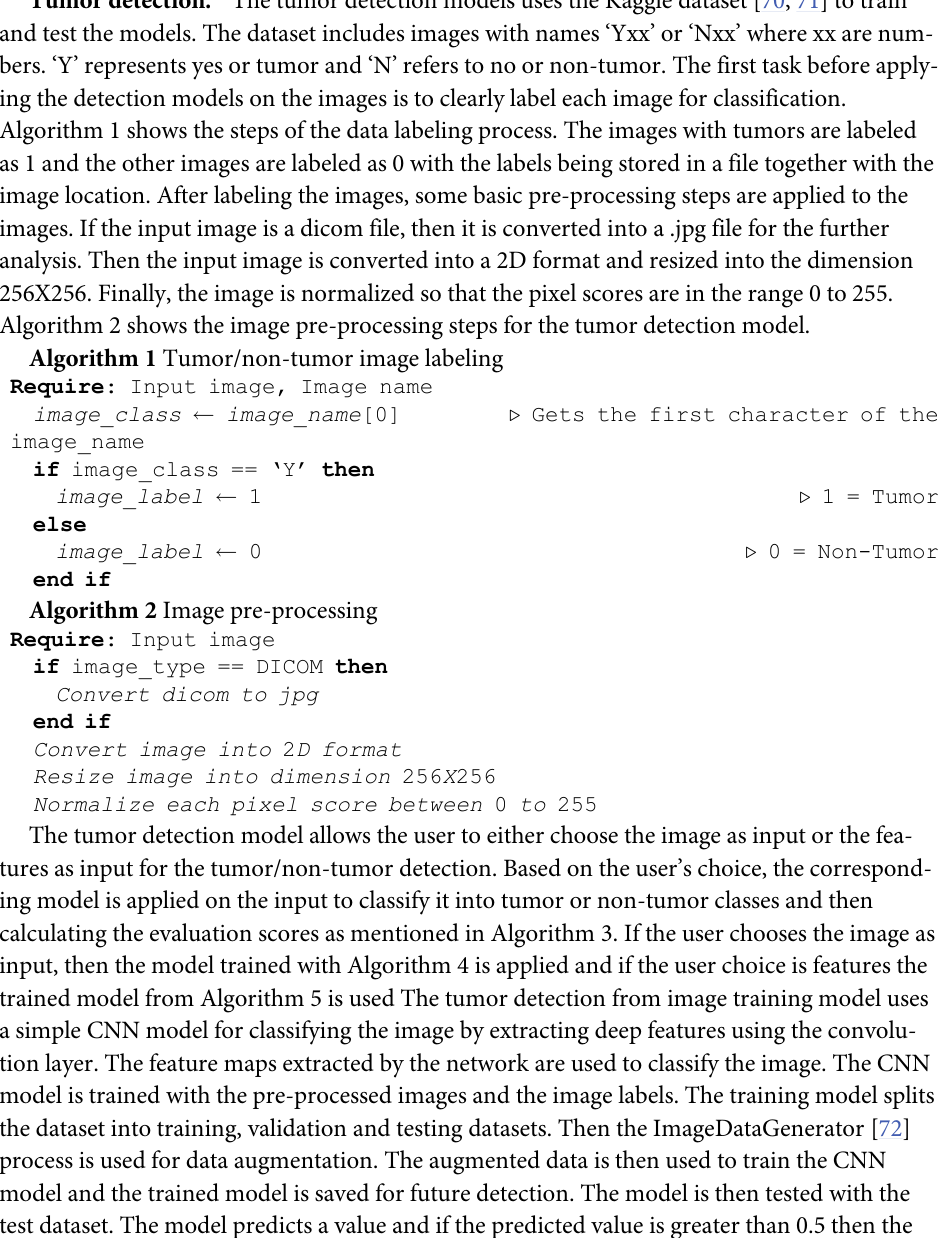
Algorithm 1 Tumor/non-tumor image labeling